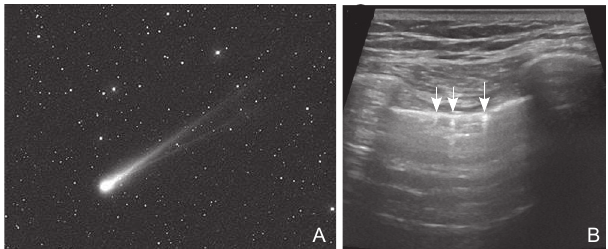
A B Figure 3 Comet tail sign. (A) Image of a comet flashing in the air with a tail; (B) Comet tail sign (arrow) generated by the gas on the lung surface in a two-dimensional ultrasound image.